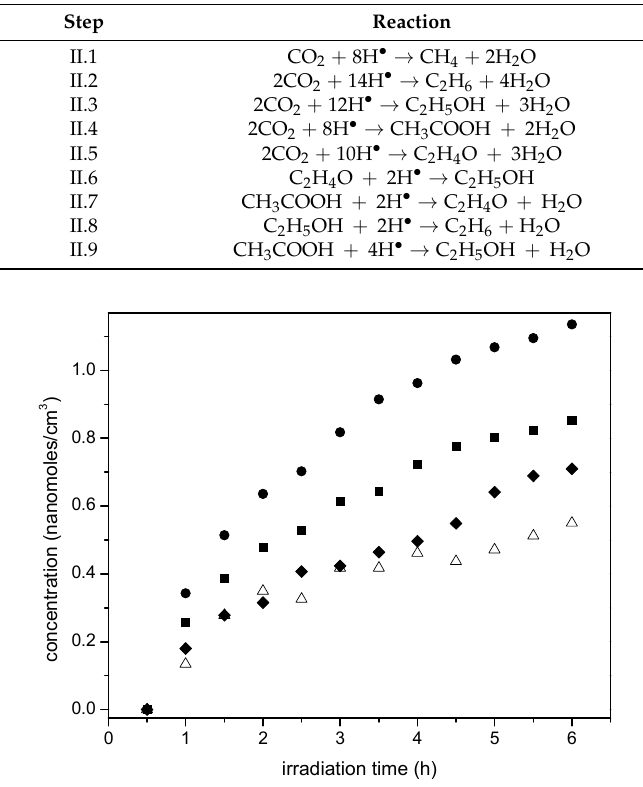
Figure 13. Methane increase with irradiation time for: ( ● ) 2.50 wt. % Pt–TiO 2 (sol-gel B), ( ■ ) 1.70 wt. % Pt–TiO 2 (sol-gel A), ( ♦ ) 1.70 wt. % Pt–TiO 2 (wetness impregnation) and ( ∆ ) Degussa P25. Standard deviation for repeats is within ±5%.